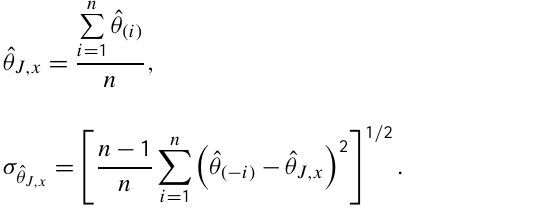
Fig. 7. (a) Frequency histogram comparing the δ 18 O ANN residuals of model M1 and M4, as well as excess kurtosis values. (b) Fre- quency histogram of the δ 18 O ANN residuals’ difference between M4 and M1 ( 1e = e M1 − e M4 ; n = 623). Values below zero indicate a lower residual in model M4 versus model M1. The labels on the x axis refer to the upper bin limit (i.e., 0.0 indicates − 0.5< 1e < 0.0)